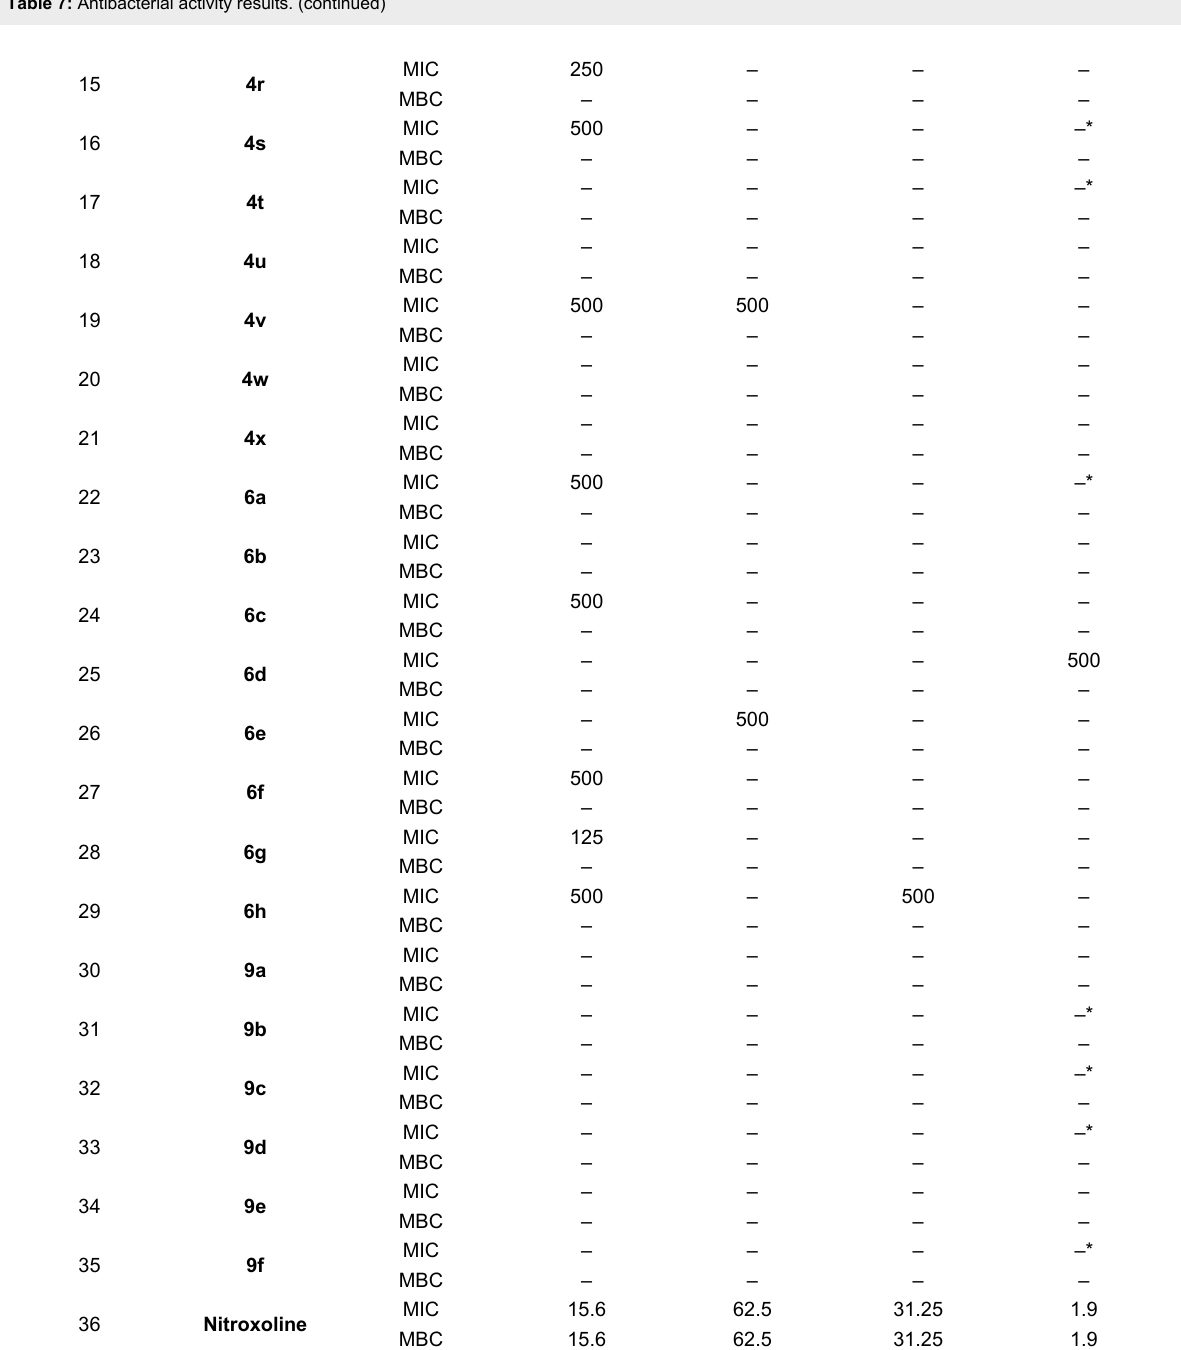
Table 7: Antibacterial activity results.